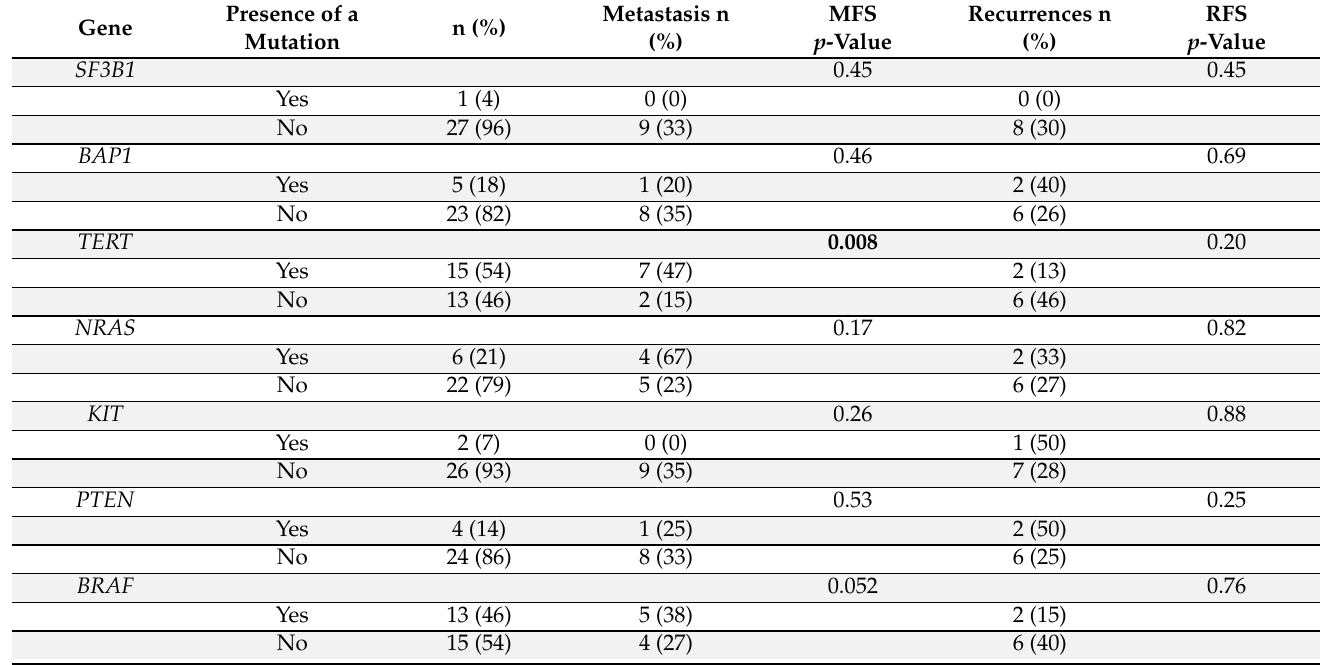
Table 2. Presence of a mutation versus metastasis-free survival (MFS) and recurrence-free survival (RFS).